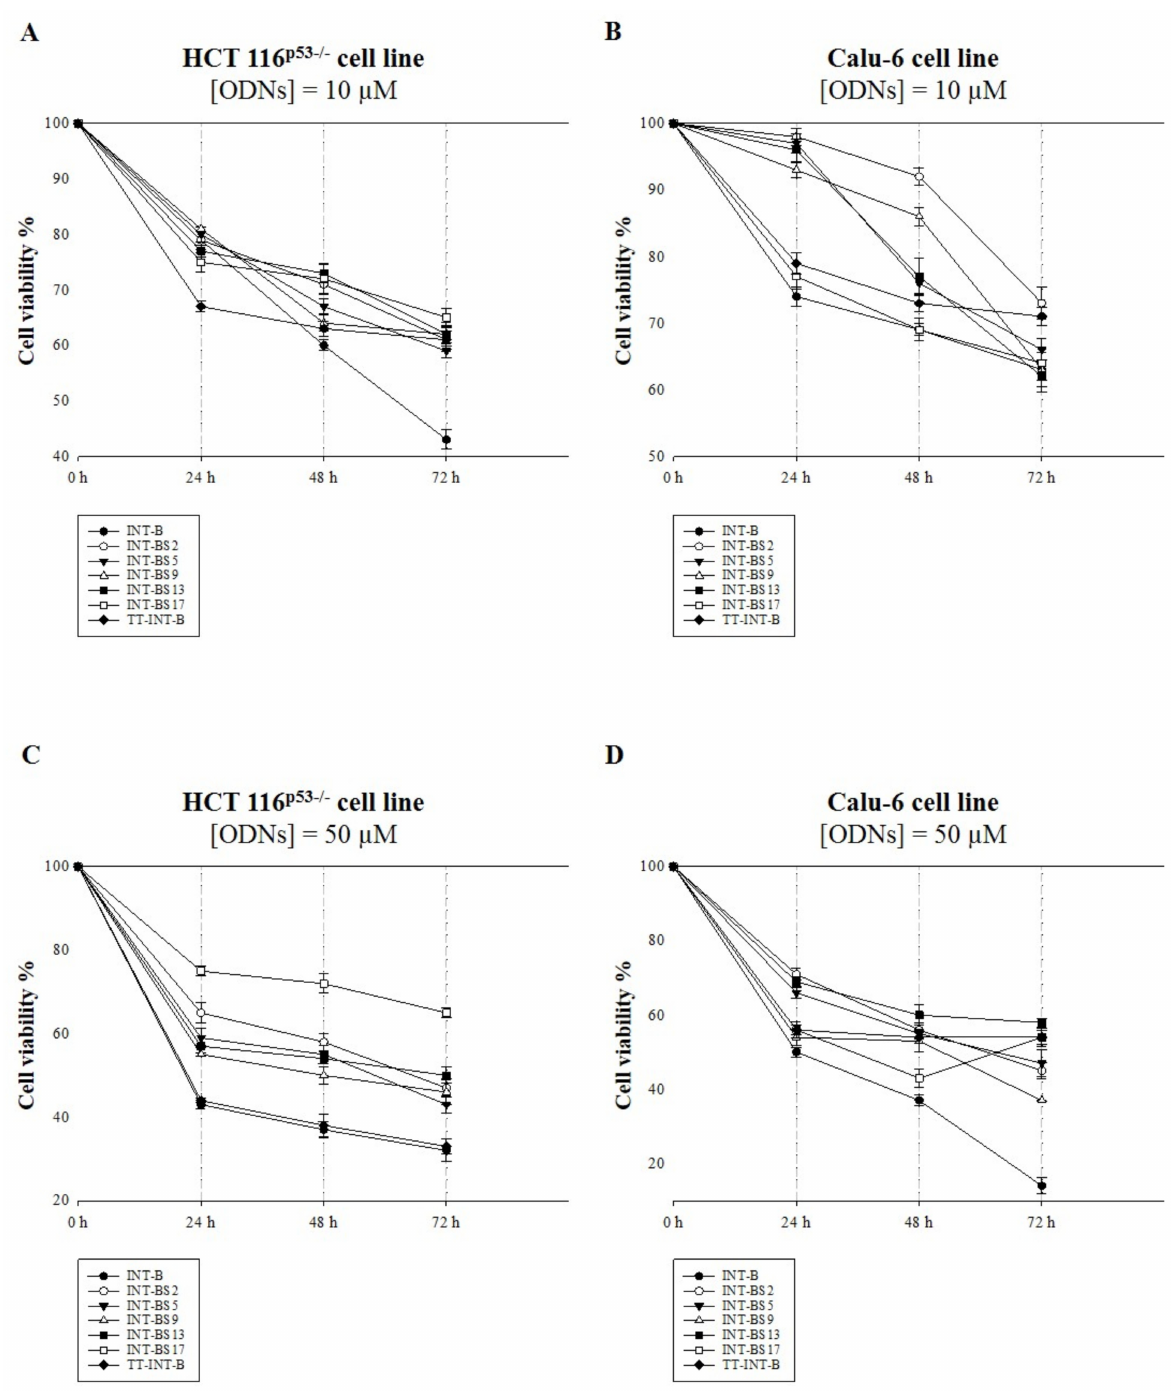
Figure 6. Antiproliferative activity of ODNs on the HCT 116 p53 − / − ( A , C ) and Calu-6 ( B , D ) cell lines. Cells were treated with two concentrations of ODNs: 10 µ M ( A , B ) and 50 µ M ( C , D ). Cell viability was assayed 24, 48, and 72 h after the addition of ODNs using an MTT assay. The results are presented as a percentage (mean ± SEM) ( n = 3) of the control